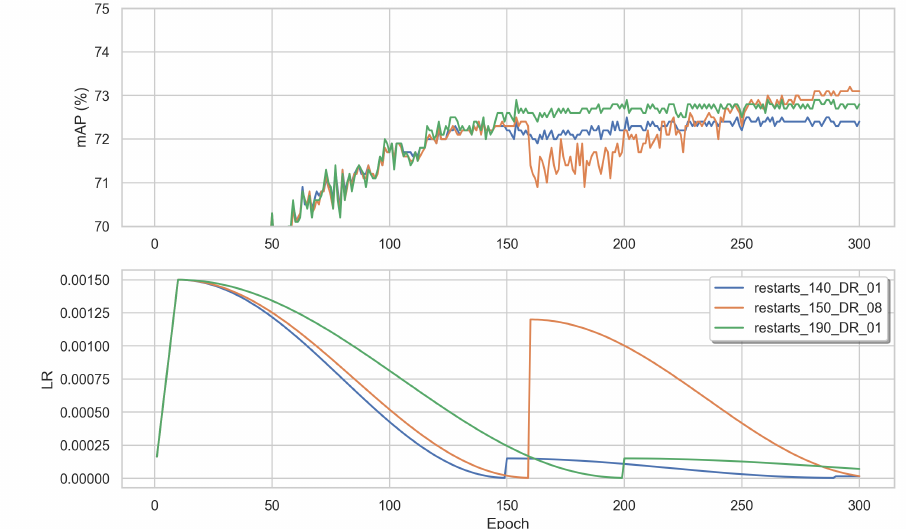
Figure 17. The mAP, loss, and learning rate per epoch when training D3 using the three losses and the BNNeck. The learning rate is linearly warmed up of 10 epochs until reaching LR base = 0.0150. The LR is then decayed using cosine annealing for 300 epochs with different restart values (140, 150, and 190) and decay rates (0.1 and